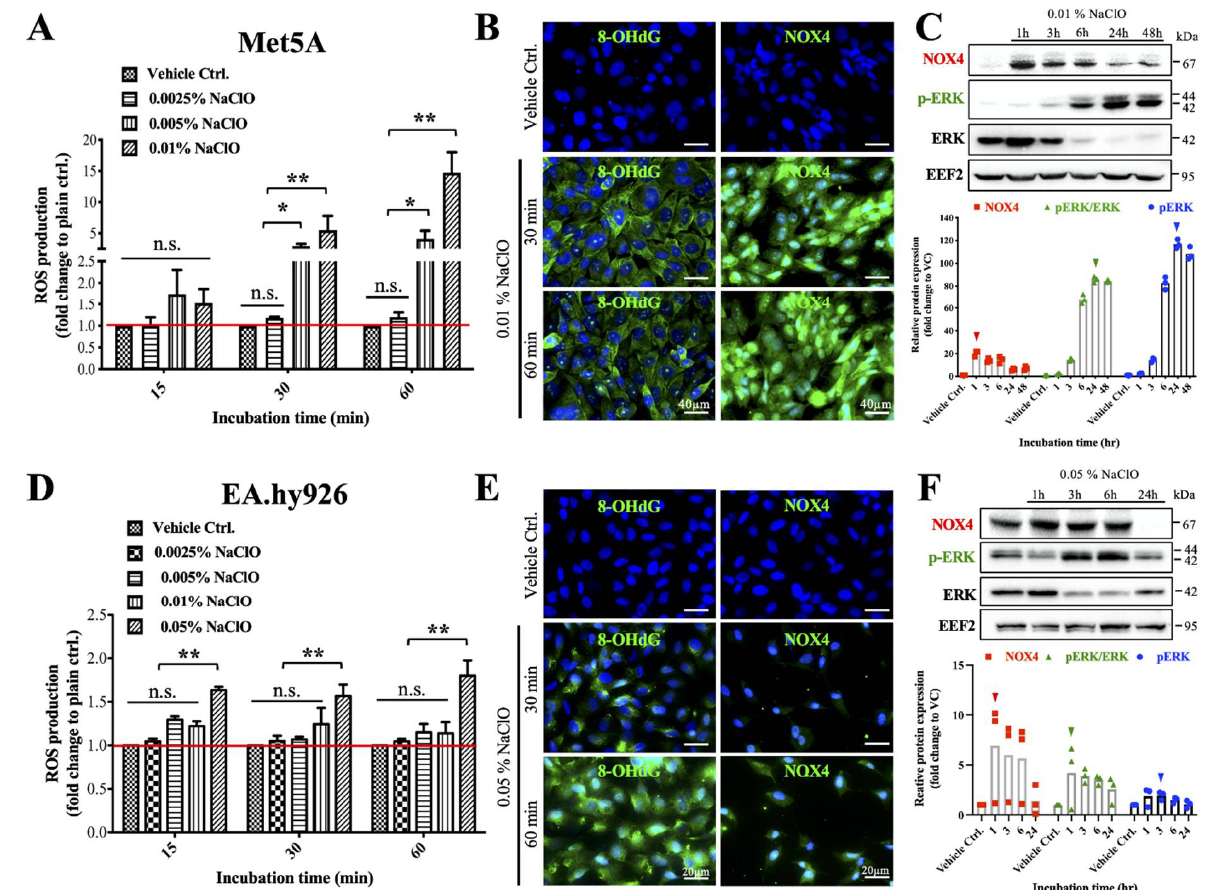
Figure 4. NaClO-induced NOX4-associated oxidative damages on both mesothelial and endothelial cells. ( A ) Significant cellular ROS production was detected when MeT5A was treated with 0.005% and 0.01% NaClO after 30 and 60 min. ( B ) Immunofluorescence results showed MeT5A with increased signals of 8-OHdG and NOX4 after being treated with 0.01% NaClO. ( C ) Time-dependent incr in NOX4 protein expression of ease was observed after 1 h. Subsequent activation of the ERK pathway as evidenced by increased expression of phosphorylated ERK after three hours. Arrowheads indicated peak protein expression. ( D ) Significant cellular ROS production was detected when EA.hy926 was treated by 0.05% NaClO after 15, 30 and 60 min. ( E ) Immunofluorescence results showed increased 8-OHdG and NOX4 signal intensity as well as round morphology of EA.hy926 after being treated with 0.05% NaClO. ( F ) Similar to MeT5A, time-dependent increases in ROS-related protein expressions on EA.hy926 under 0.05% NaClO were quantified. A peak of NOX4 protein expression was observed after 1 h. Then, activation of the ERK pathway was demonstrated by increased expression of phosphorylated ERK after 3 h; however, the protein expression of phosphorylated ERK went back to normal after 24 h. Peak protein expression was labeled in arrowheads. Triplet experiments were performed for cellular ROS production assay. For each experimental condition, 10 images were evaluated, and representative images were presented. Whole membrane images of western blotting could be found in Figure S4. Asterisks indicate significant differences between groups (* p < 0.05, ** p < 0.01, N.S. not statistical